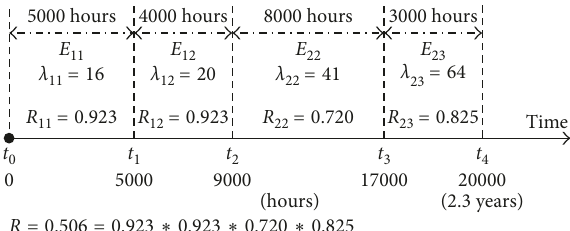
Figure 5: Mission reliability evaluation of a traffic signal